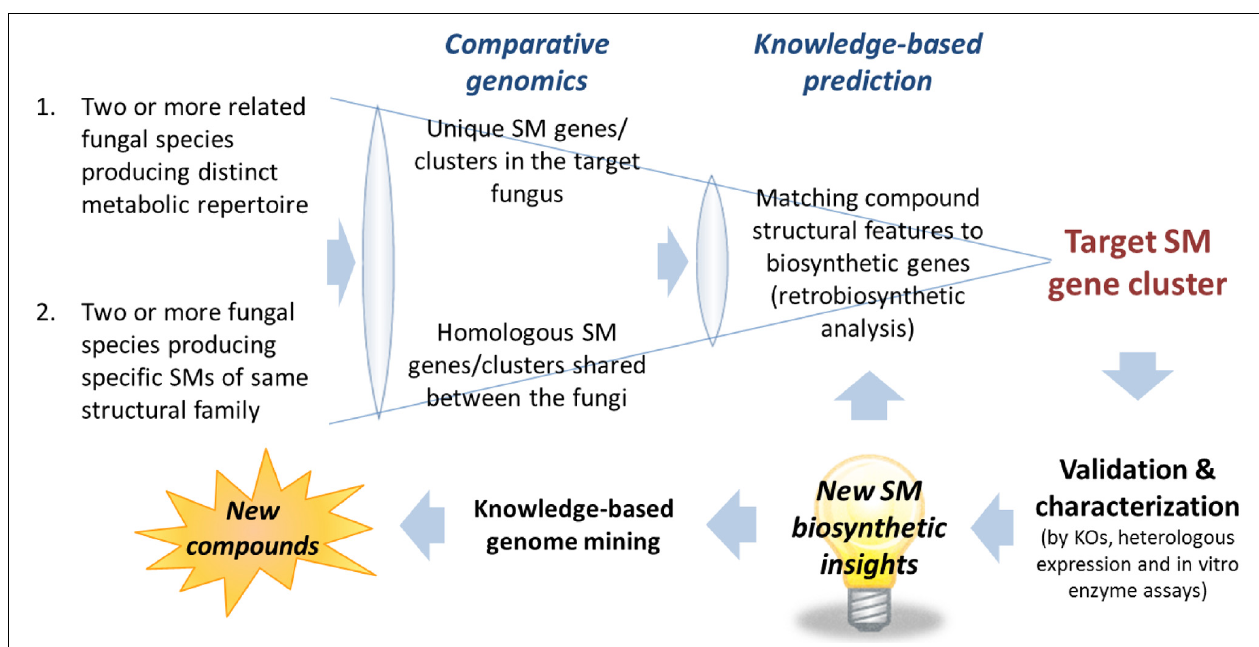
FIGURE 2 | Comparative genomics and knowledge-based prediction strategies for targeted SM gene cluster discovery. New biosynthetic knowledge and insights into gene-to-molecular structure relationship would be useful for target SM gene cluster predictions and knowledge-based genome mining for discovery of novel SM